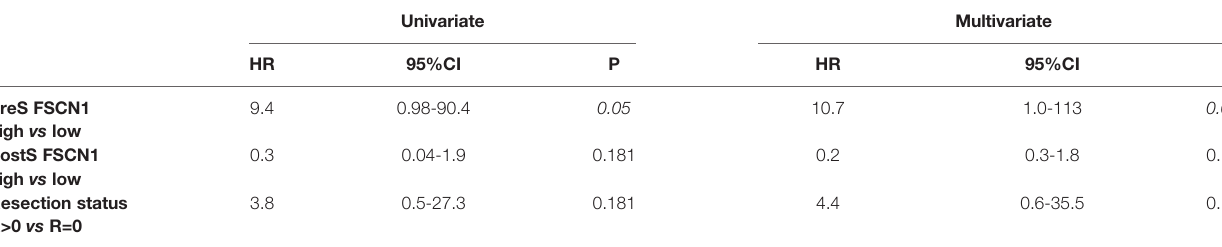
Univariate andMultivariateCoxregression analysesofDFSinpatients strati fi ed fortheindicated factorsinhigh andlowclasses forPreSFSCN1levelsand PostSFSCN1levels(according to the median value of FSCN1 distributions in serum samples drawn before and after surgery). HR, hazard ratio; CI, con fi dence